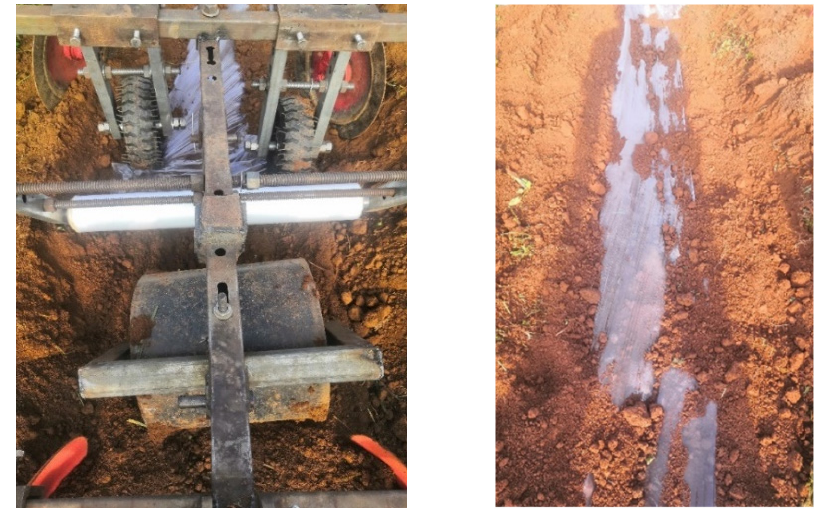
Figure 12. The comprehensive test in the field. Table 7. The results of the verification test.